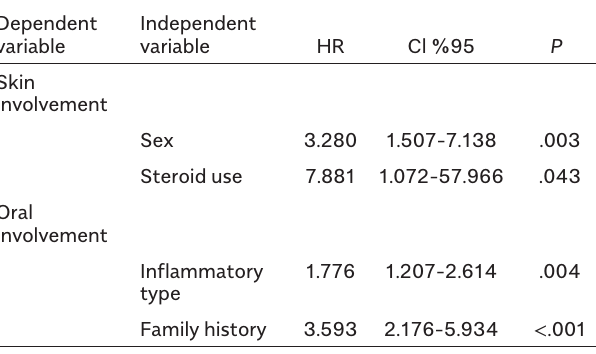
Table 5. Multivariate Cox Regression Analysis of Independent Risk Factors Associated with Mucocutaneous Manifestations